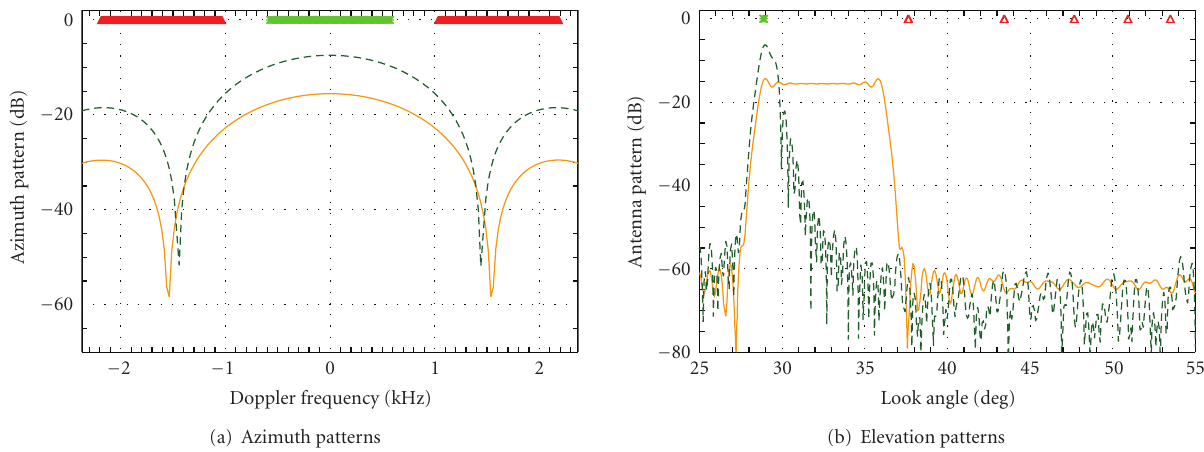
Figure 17: Transmit (solid line) and receive patterns (dashed line) of the reflector antenna system. All patterns are normalized to the gain achieved for a optimum aperture e ffi ciency.